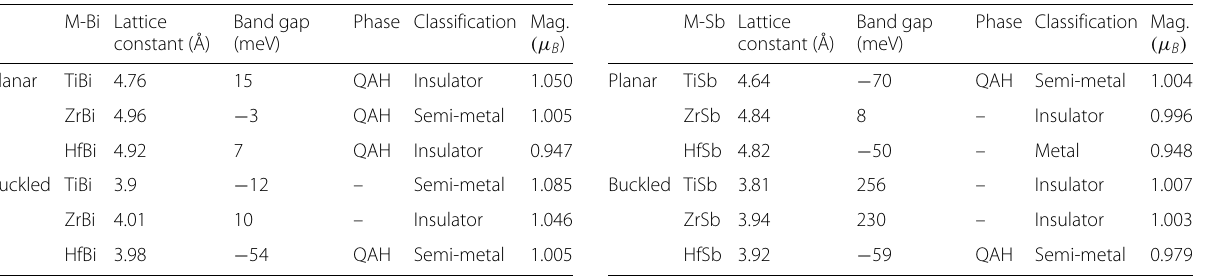
Table 2 Calculated equilibrium lattice constants, system band gaps, magnetic moment, and topological phase of planar and buckled M-Sb